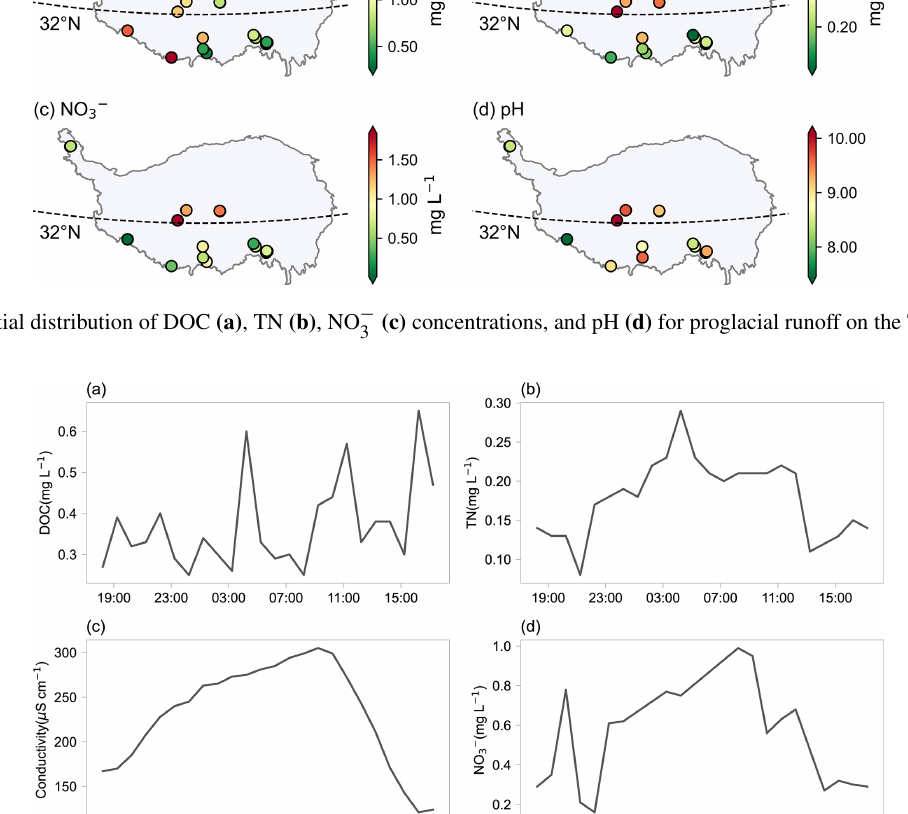
Figure 9. The 24h time series of DOC (a) , TN (b) , conductivity (c) , and NO